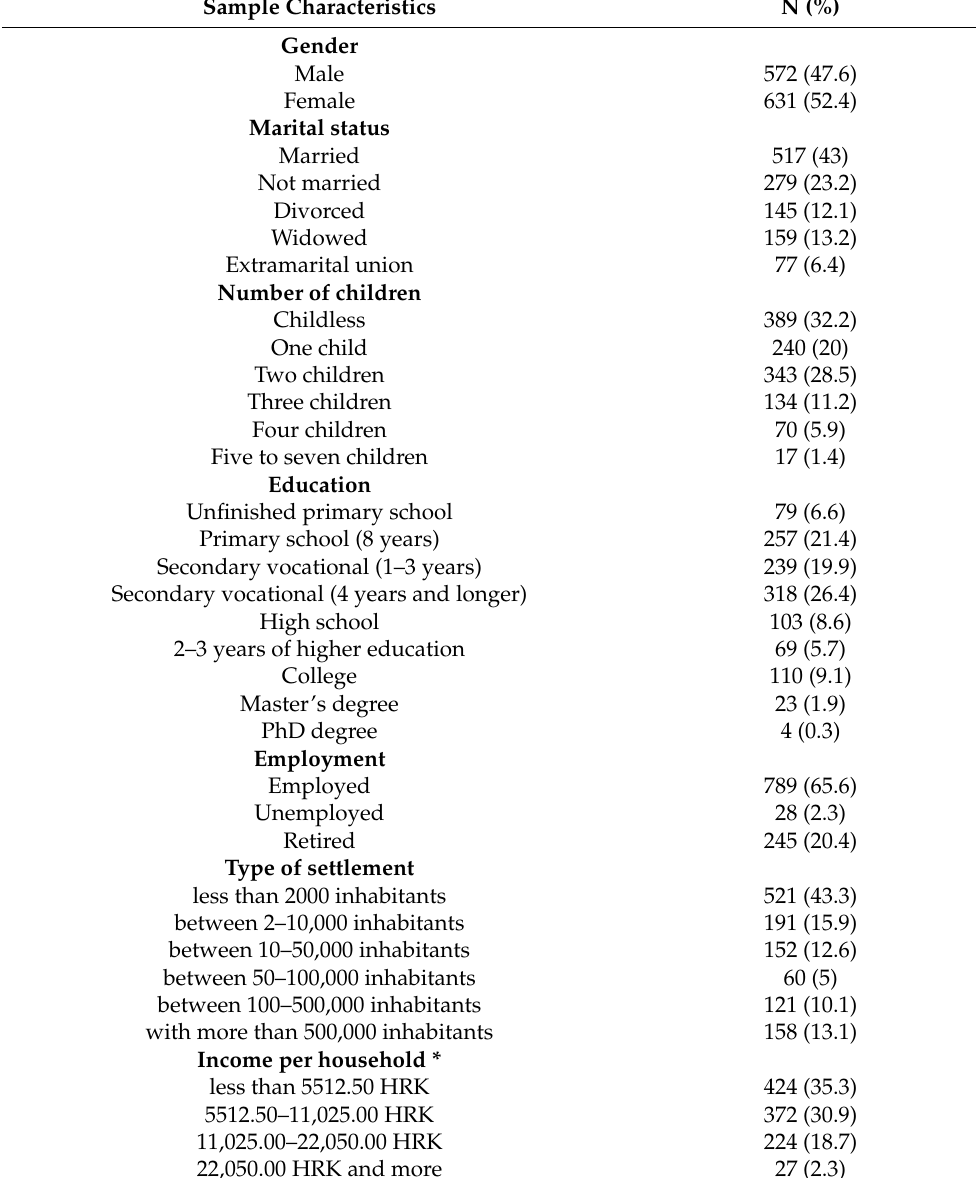
Table 3. Sociodemographic characteristics of respondents (N =